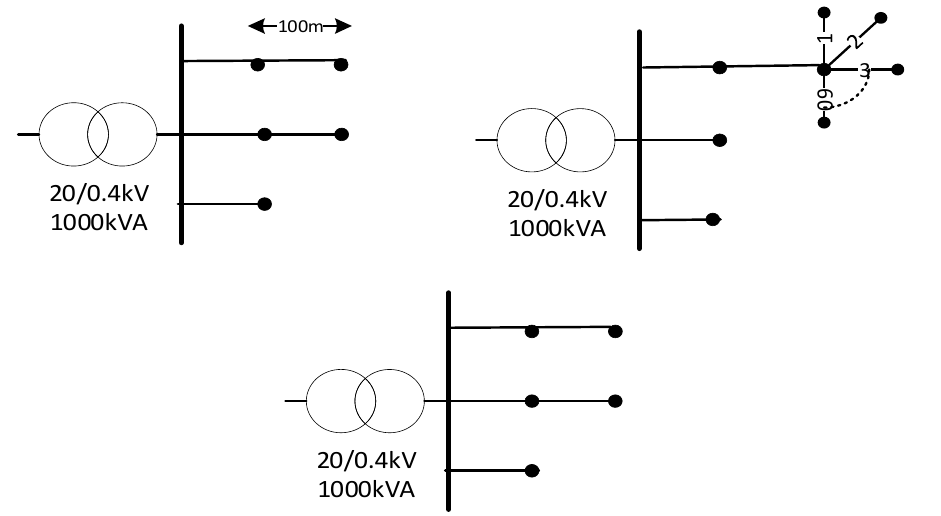
Figure 4. Domestic urban networks for 0% (upper left), − 5% (right) and +5% (middle) MV network voltage changes.